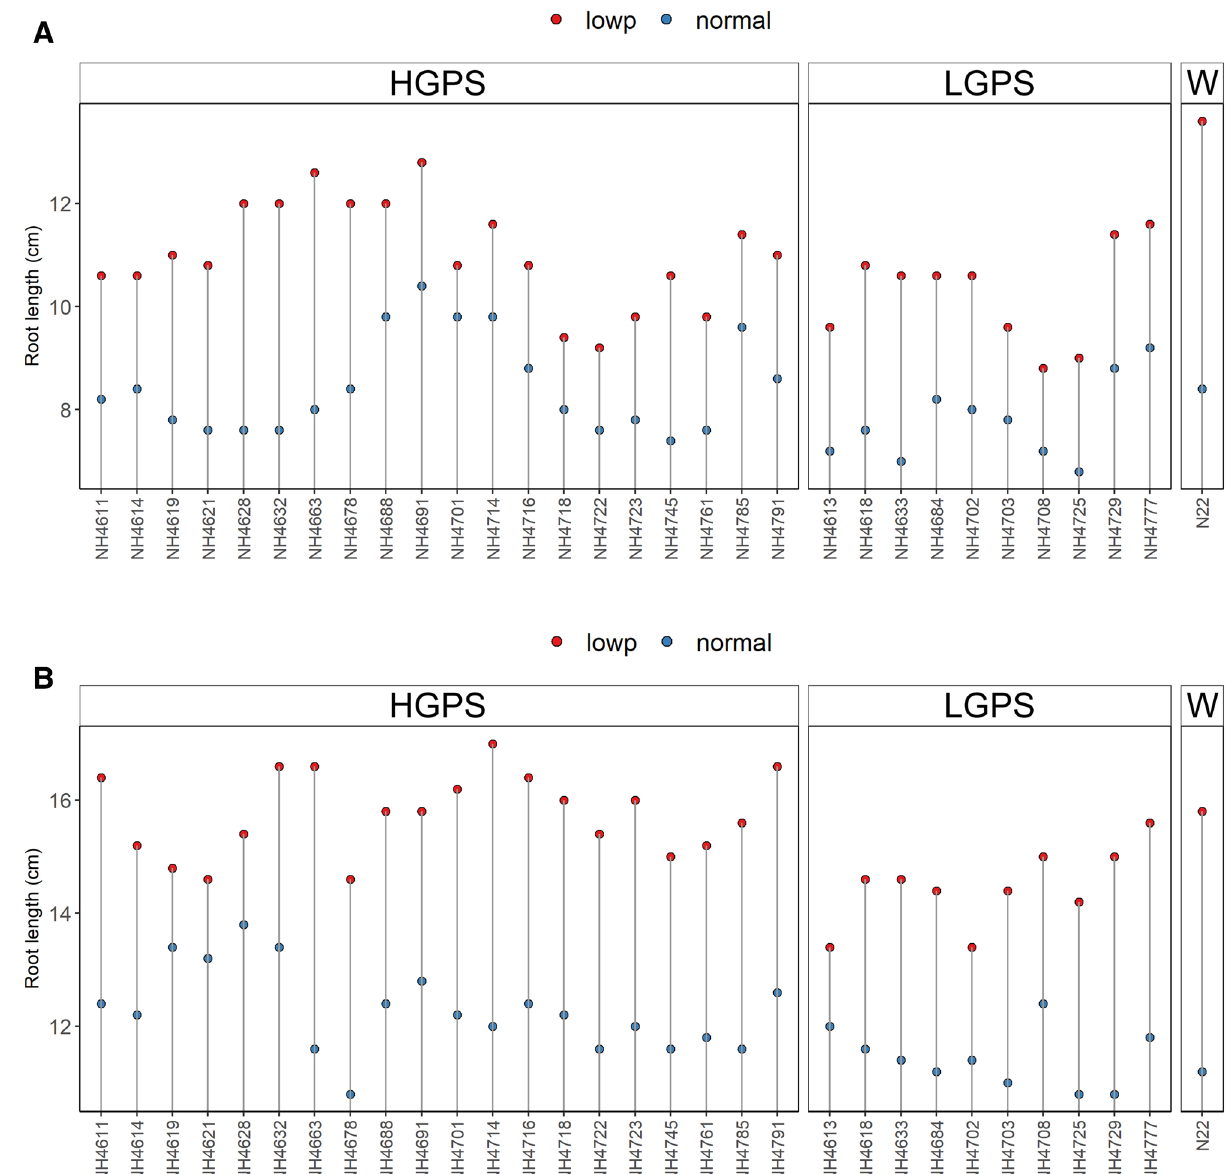
Figure 2. Root length of seedlings obtained from germination of seeds harvested from low P (shown as red dots) and normal P (shown as blue dots) fields. Wild type N22 (W), high grain P mutant seedlings (HGPS), and low grain P mutant seedlings (LGPS) were grown under normal P condition. ( A ) Root length at 12 days of germination. ( B ) Root length at 24 days of germination. The values represent the mean of 100 HGPS, LP-LGPS and LP-N22 showed significant increase in root length as compared to NP-HGPS, NP-LGPS, and NP-N22 (Fig. 2). Shoot length was also recorded at 12 and 24 days of germination. NP-HGPS, NP-LGPS, and NP-N22 did not show any significant variation in shoot length, however, LP-HGPS showed higher shoot length than LP-LGPS at both the time points. The mean shoot length of LP-HGPS and LP-LGPS was 8.4 cm and 6.7 cm at 12 days, and 23 cm and 21.6 cm at 24 days, respectively (Fig. 3). Interestingly, one of the HGP mutants ( NH4614 ) showed similar shoot length under LP and NP at 24 days of germination. In contrast, LGP mutants such as NH4777 , NH4684 , and NH4725 showed severe impact on shoot length under LP when compared with NP. NP-HGPS, NP-LGPS, and NP-N22 did not show significant variation in root and shoot dry weight, how- ever, LP-HGPS showed higher root and shoot dry weight than LP-LGPS at both the time points (Figs. 4, 5). The average root dry weight of LP-HGPS and LP-LGPS was 0.017 and 0.009 g at 12 days, and 0.024 and 0.022 g at 24 days, respectively. LP-HGPS exhibited 89% and 10% more root dry weight than LP-LGPS at 12 and 24 days (Fig. 4). The average shoot dry weight of LP-HGPS and LP-LGPS was 0.033 and 0.027 g at 12 days, and 0.054 and 0.053 g at 24 days, respectively. LP-HGPS exhibited 22% and 2% more shoot dry weight than LP-LGPS at 12